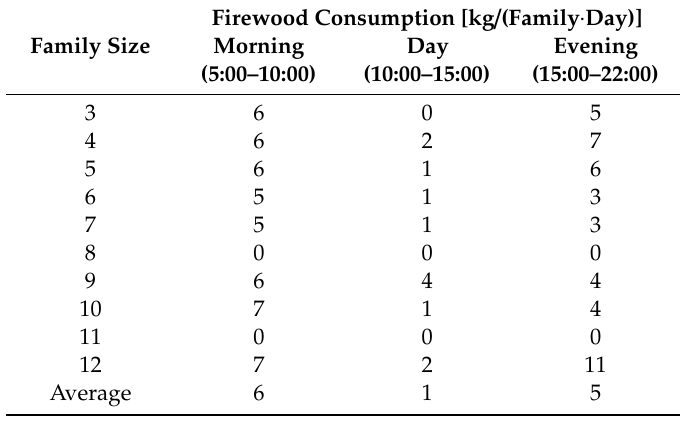
Table 1. Firewood consumption for di ff erent time of day by family size.